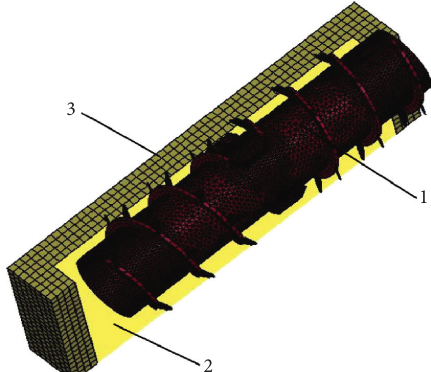
Figure 5: Simplified finite element model of the silage and loading cutter roller: 1, loading cutter roller; 2, inner silage (SPH); 3, outer silage (FEM).